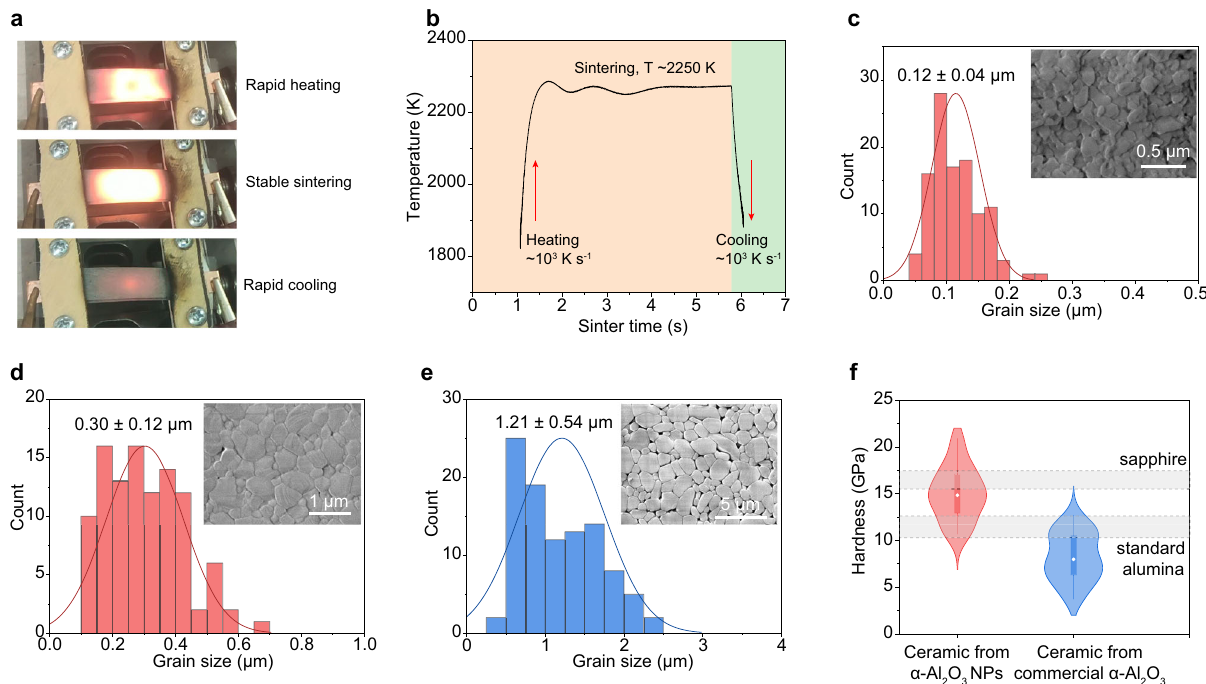
Fig. 5 | Sintering of the nanograined alumina ceramics. a Picture of the carbon papers during heating, sintering, and cooling. b Real-time temperature measure- ment during the alternating current sintering (ACS) process. c Grain size distribu- tion of the alumina ceramic by ACS sintering using the α -Al 2 O 3 NPs as precursor. Inset, scanning electron microscopy (SEM) image of the ceramic. d Grain size dis- tribution of the alumina ceramic by two-step pressureless sintering (TS-PS) using the α -Al 2 O 3 NPs as precursor. Inset, SEM image of the ceramic. e Grain size